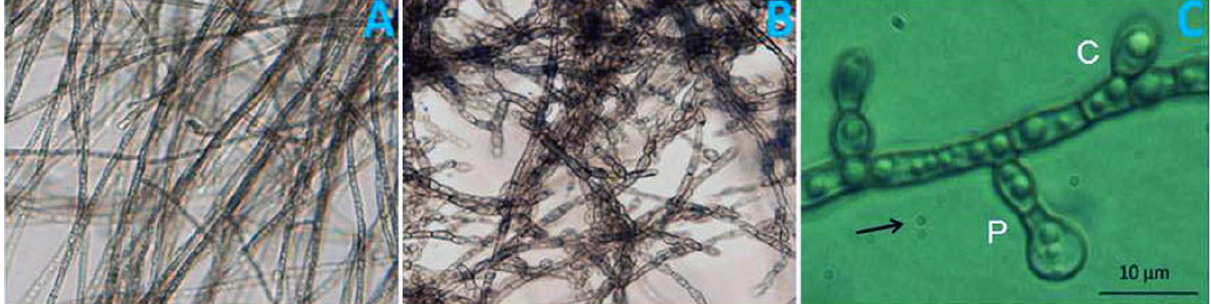
Figure 2. ( A ) Fonsecaea pedrosoi cells from a 15-day culture on SDB with antibiotic, 200x. ( B ) Cellular rounding (arthroconidium-like) and increase of conidiogenesis after two days of co-culturing with the B. subtilis strain , 200x. ( C ) Hyphal induction of lateral conidiophore (P, phialid-type) growth and conidiogenesis (C), 1000x (bacteria, arrow).